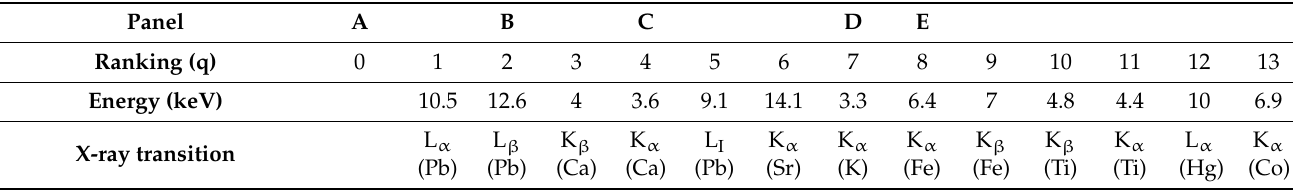
Table 6. The principal energies (elements’ emission series) emerging from the GS evaluated from the isolated spectra. The series has been ordered following the incidence criterion: the first position is occupied by the series, which, if removed, generates a similarity change of more than 10% with respect to the value of [ A ] involving the largest number of pixels; k 0 the second place is held by the series, which involves the second largest number of pixels and so on. The energy of the emission has been reported in keV and classified according to the X-ray nomenclature. The letters refer to Figure 7 and specify the series that have been removed before the calculation of the corresponding set of similarity